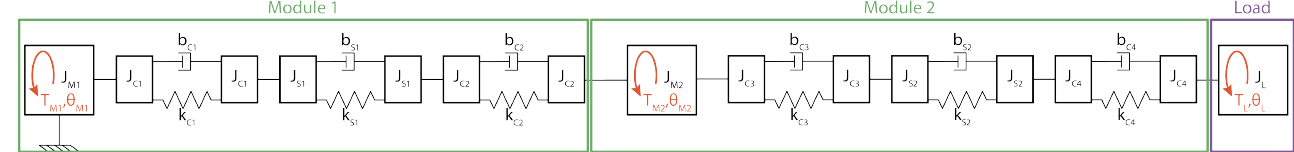
Figure 1. Dynamic model of the